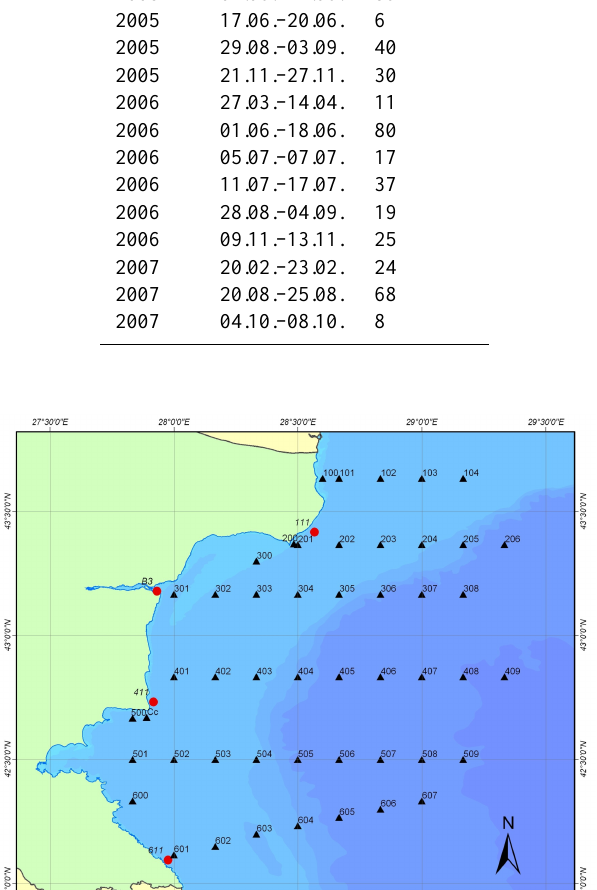
Fig. 7. Monitoring scheme of IO-BAS.